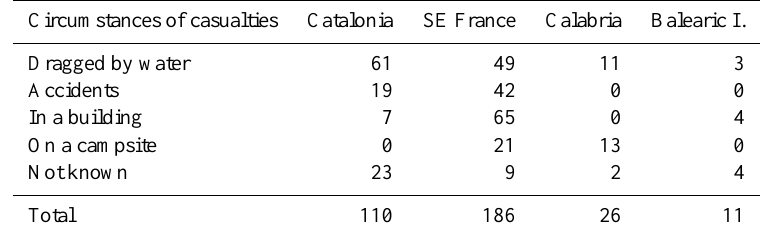
Table 7. Circumstances in which casualties occurred in the different FLOODHYMEX study